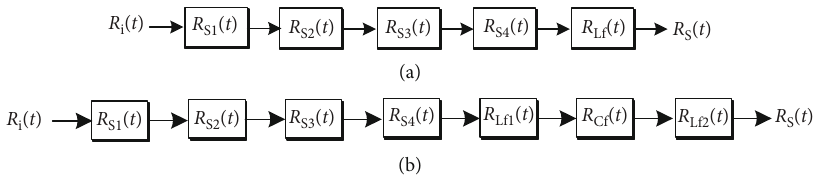
Figure 7: Serial block diagram of the full bridge with (a) L fi lter and (b) LCL fi